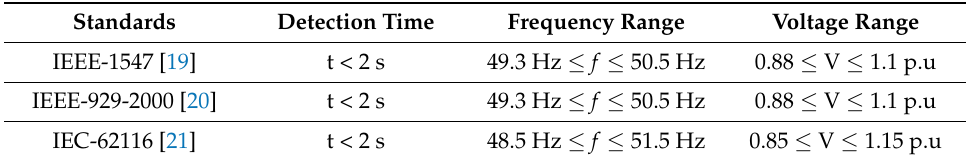
Table 1. Common standards for islanding